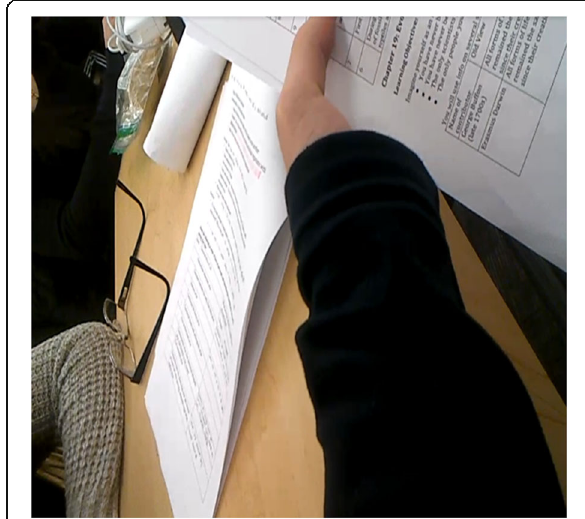
Fig. 3 Example visual from the LA point-of-view